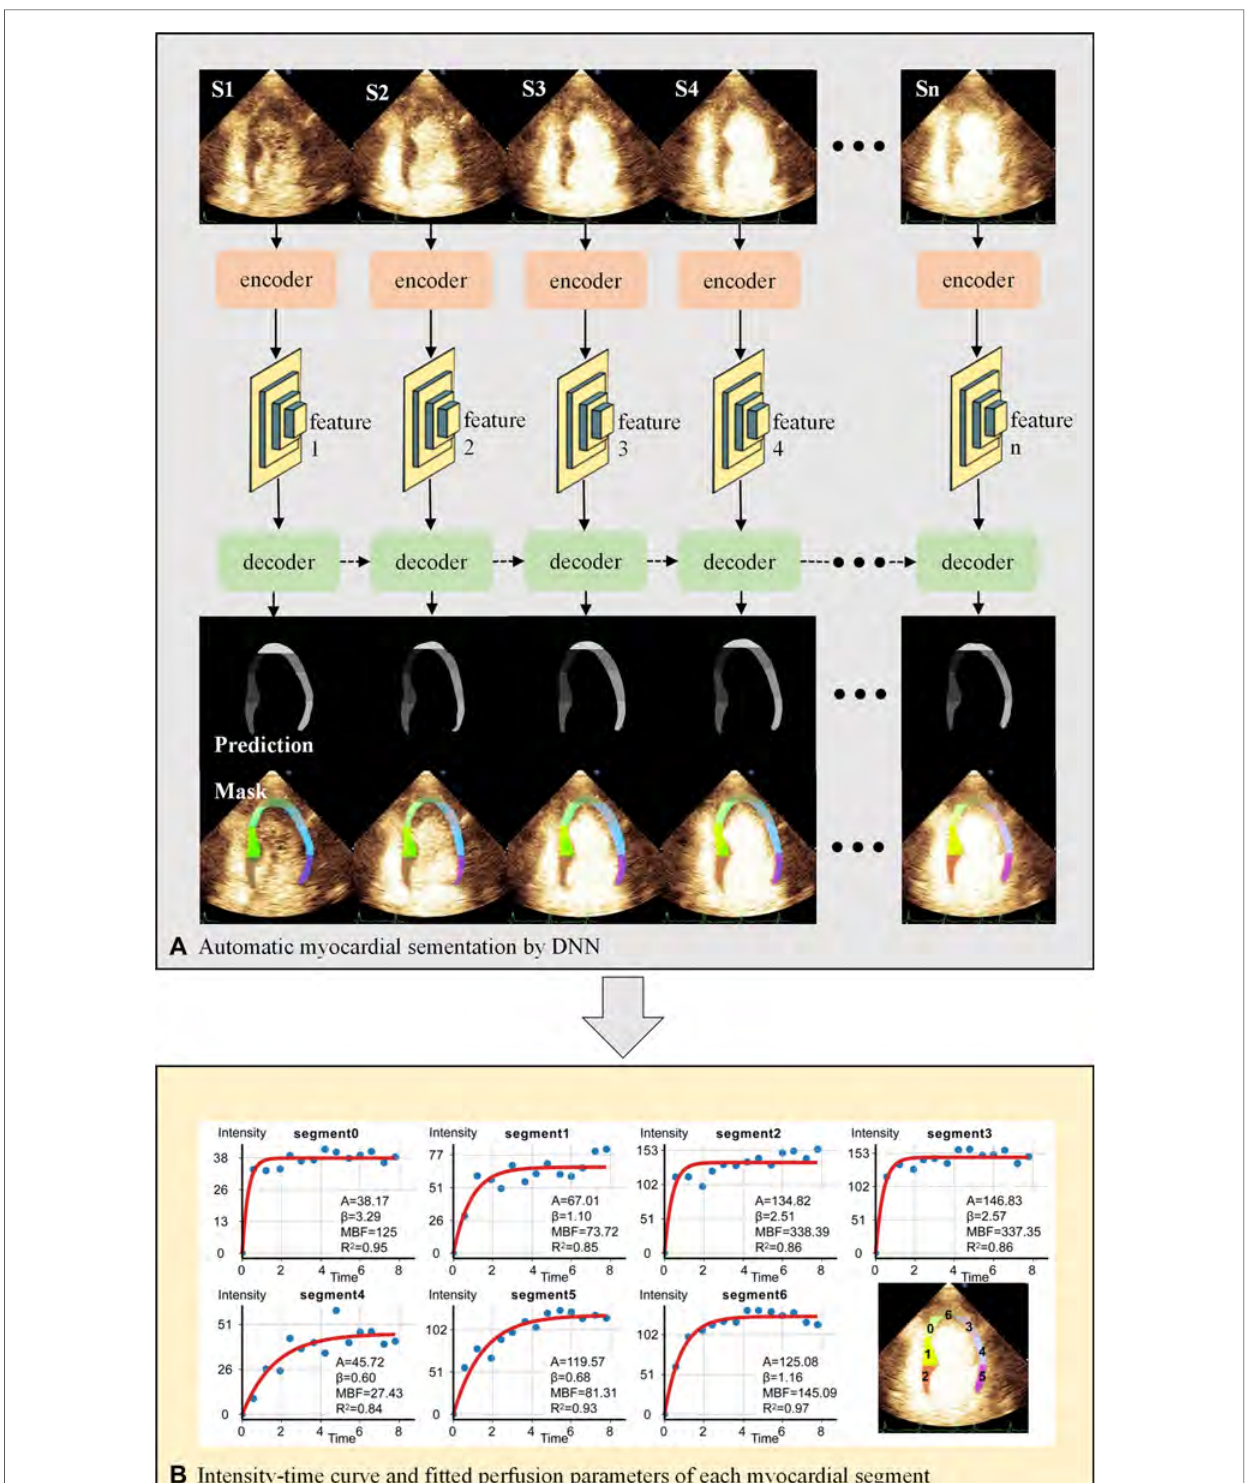
FIGURE 2 Work fl ow of MCE quantitative analysis. ( A ) The U-net-based encoder extracts the image features 1-n of each end-systolic frame, which are then put into the decoder for myocardial segmentation. The decoder consists of hierarchical ConvLSTMs and can incorporate temporal information between MCE frames. The dashed arrows represent the temporal information of the myocardium in the previous frame as additional features to enhance the segmentation of the current frame. ( B ) Automatic calculation of perfusion parameters for each myocardial segment by fi tting equation. DNN, deep neural network; S1-n, end-systolic frames of consecutive cardiac